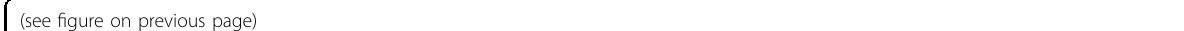
Fig. 2 The canonical stress granule assembly pathway. (1) Formation of stress granules (SGs) can be triggered by diverse cell damaging conditions, including viral infection, oxidative stress, heat shock, nutrient deprivation, ultraviolet radiation or proteotoxic stress. Particular stress conditions are detected by speci fi c kinases — protein kinase R (PKR), haem-regulated inhibitor (HRI), general control non-derepressible-2 (GCN2) and pancreatic eIF2 α kinase (PEF) — that then become activated and (2) phosphorylate eukaryotic translation initiation factor 2 subunit alpha (eIF2 α ). (3) eIF2 α is involved in the formation of translation initiation complexes and, when phosphorylated, leads to dissociation of these complexes and to translational arrest. (4) mRNAs, 40S ribosomal subunits, and proteins involved in translation start to accumulate and to assemble together, along with other proteins that are recruited to the forming SGs. This primary aggregation process produces a stable SG core. RNA-binding proteins (RBPs) that constitute SG cores include ras GTPase-activating protein-binding protein 1 (G3BP1), T-cell intracellular antigen-1 (TIA-1), tristetraprolin (TTP) and fragile X mental retardation protein (FMRP). (5) A secondary aggregation step resulting from additional, albeit weaker, intermolecular interactions originate the shell of the SGs. RBPs recruited in this step include heterogenous nuclear ribonucleoprotein A0 (hnRNPA0), hnRNPA1, hnRNPA2B1 and RNA-binding protein EWS (EWSR1). (6) When stress conditions abate, SGs are either disassembled by molecular chaperons or (7) are cleared by autophagy. (8) Disassembly allows for a rapid recovery of protein